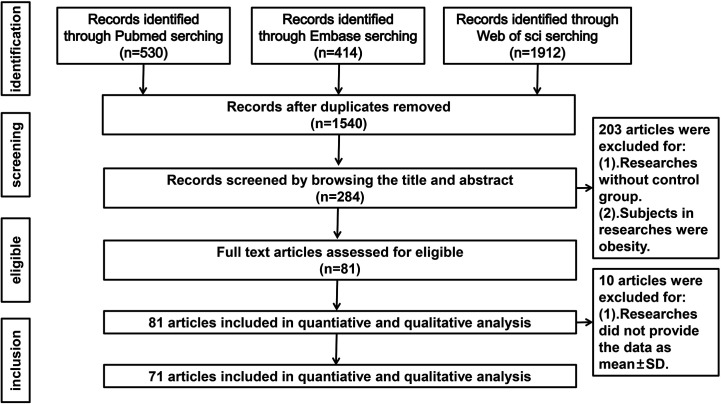
Flow chart of study inclusion in systematic review and meta-analysis.